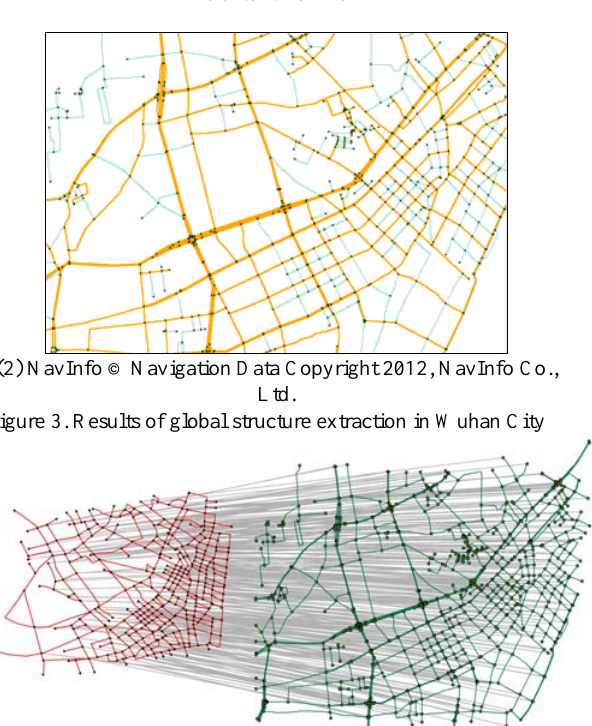
Figure 4. Matching result from an original view